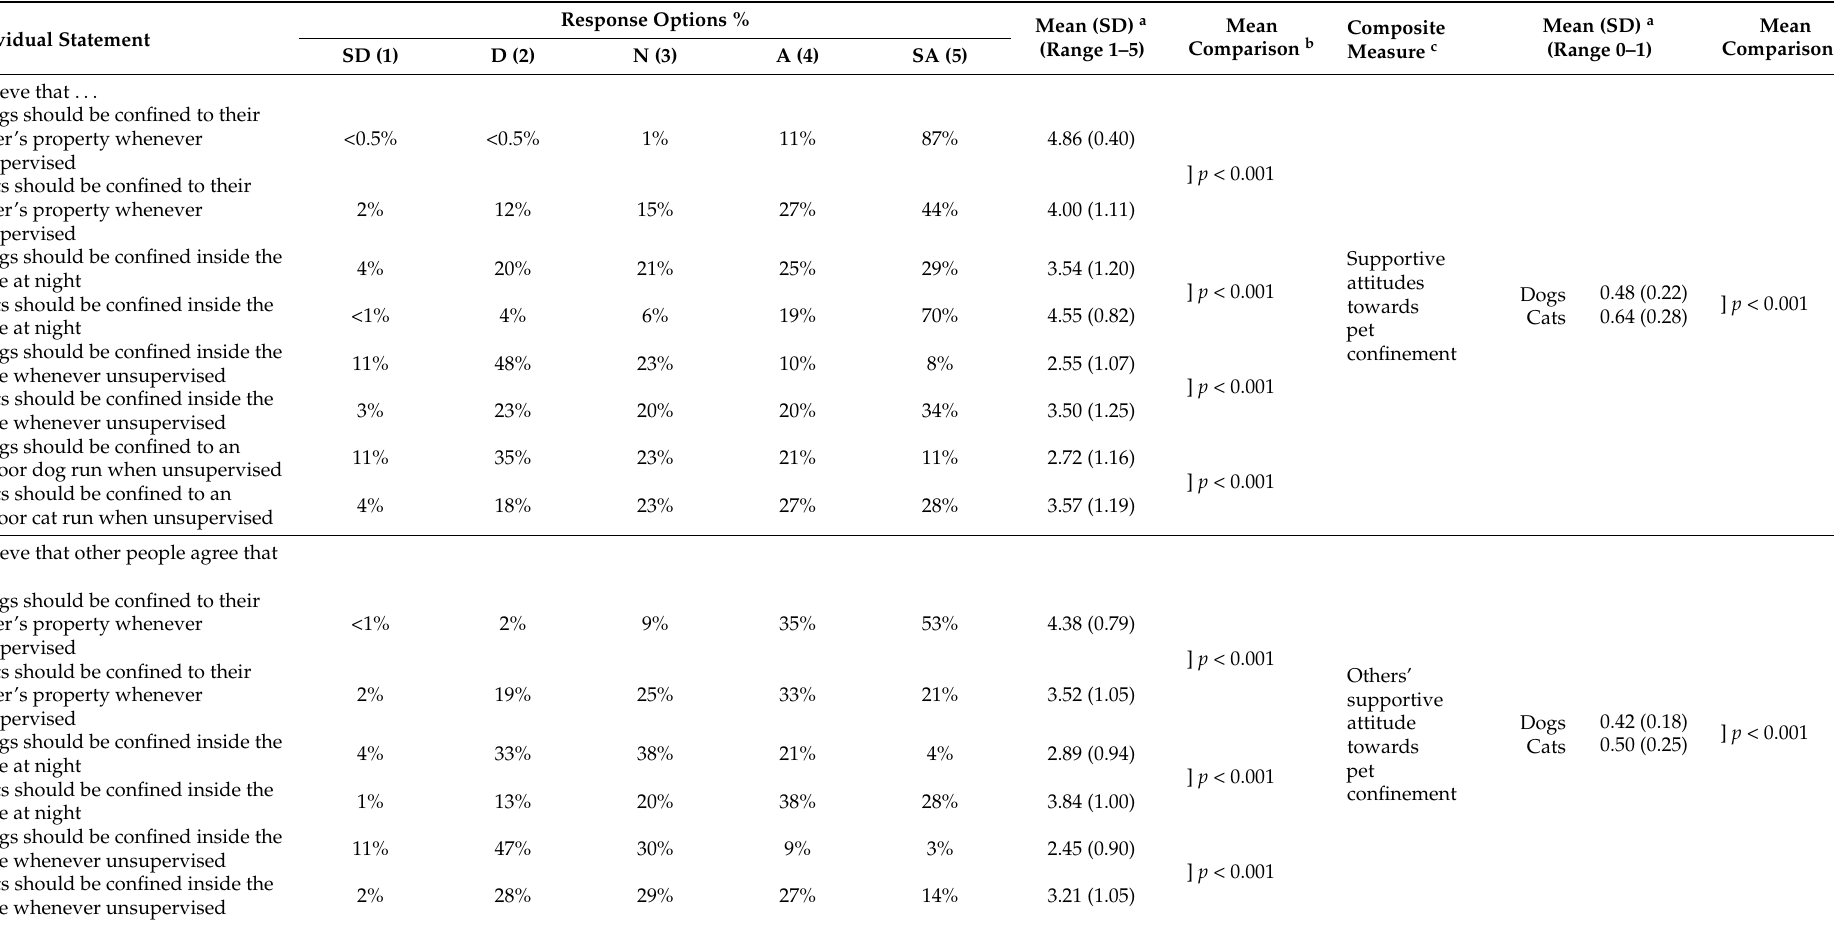
Table 2. Comparison of dog owners’ ( n = 1529) and cat owners’ ( n = 1346) responses to statements regarding attitudes and opinions towards confinement of their pet dogs and